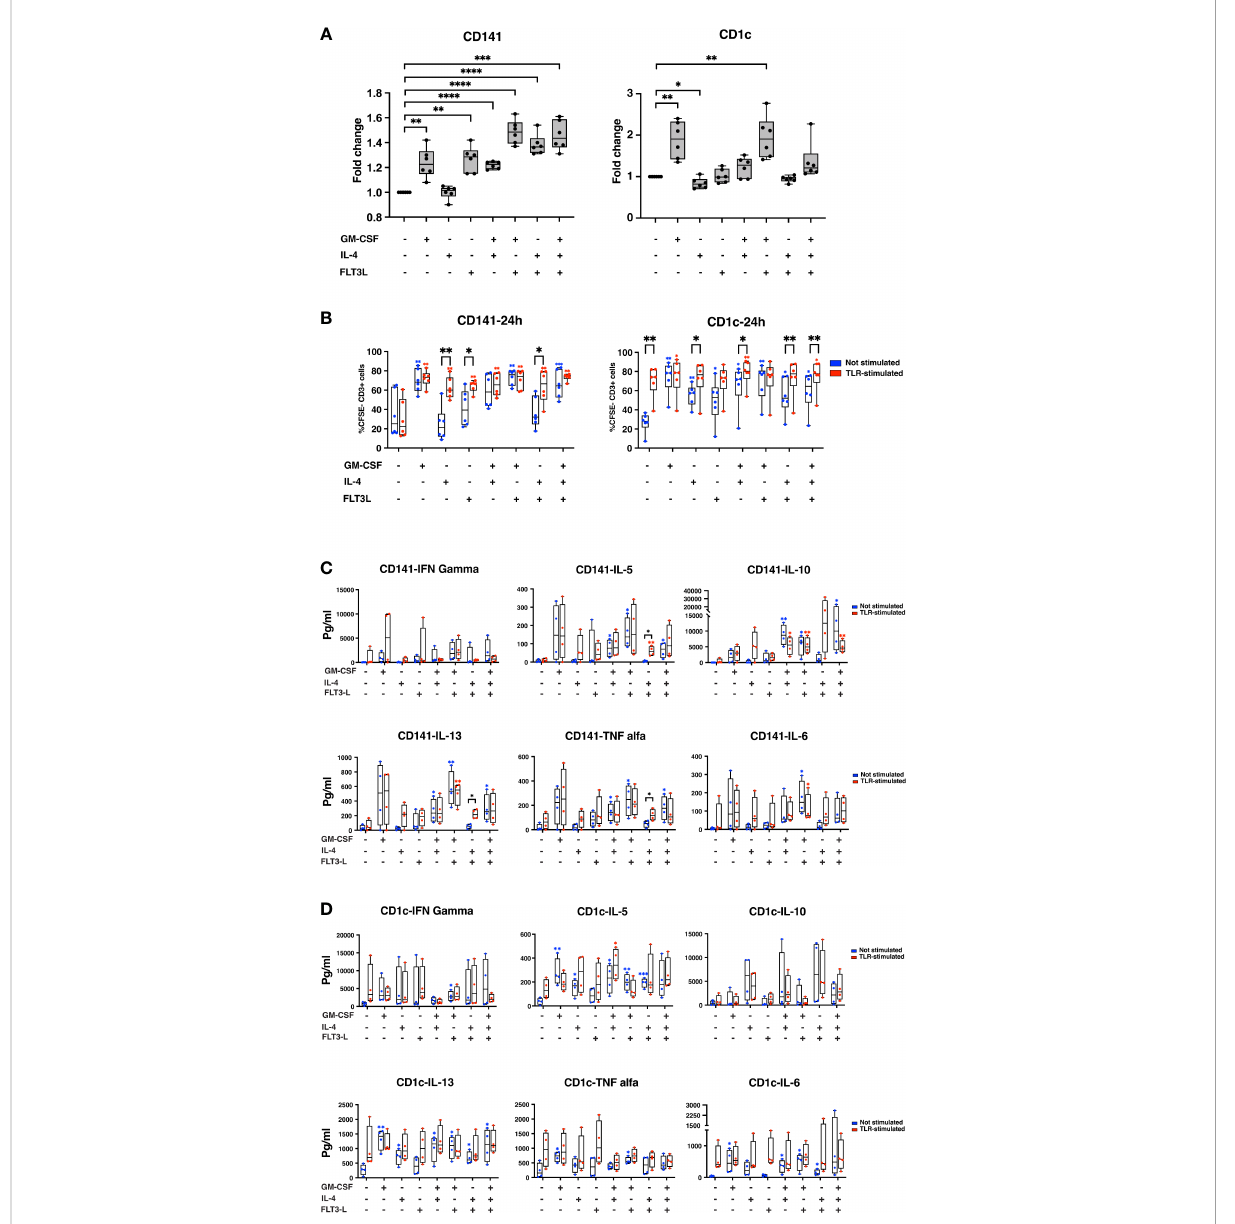
FIGURE 4 Cytokine treatment improves the performance of both CD141+ and CD1c+ cells. (A) CD141+ and CD1c+ cells were seeded in 96-well plates in different media conditions, as indicated in the graph. A day after, FITC-dextran was added to each media condition, and cells were kept at 37°C or 4°C for 90min. Those cells which were positive for FITC, are considered as cells that successfully uptake dextran-FITC. The percentage of positive cells for FITC was measured in each media condition, and the value from each condition was normalized with CTRL cells to calculate fold change. Graphs represent six biological replicates. The data is represented as fold change ± SD. Student ’ s t test analysis was used for calculation of p values ****, p < 0.0001; ***, p ≤ 0.001; **, p ≤ 0.01; *, p ≤ 0.05. (B) CD141+ and CD1c+ cells were sorted and cultured in different media conditions in the presence or absence of stimuli. After 24hrs, DCs were extensively washed and cocultured with CSFE stained monocyte-depleted PBMCs in the proportion of 1:5. “ TLR-stimulated ” denotes addition of Poly I:C to CD141+ cultures and R848 to CD1c+ cultures in contrast to “ Not Stimulated ” without these compounds. Cells were incubated at 37°C for eight days. IL-2 and IL-7 were added to the media every second day. Samples were analyzed using fl ow cytometry. Graphs indicate a summary of six biological replicates, and data represent the percentage of CSFE- CD3+ cells ± SD. Paired Student ’ s t test analysis was used for the calculation of p-values ***, p ≤ 0.001; **, p ≤ 0.01; *, p ≤ 0.05. (C, D) Media of MLR experiments were collected after eight days, and cytokine secretion was analyzed for each treatment as indicated. The data are shown as pg/ml, and paired student ’ s t test analysis was used for the calculation of p value ***, p ≤ 0.001; **, p ≤ 0.01; *, p ≤ 0.05. Graphs summarized results from four biological replicates. In (B-D) , the blue star showing summary of p values for not stimulated samples in comparison with control cells, and red star showing summary of p value for stimulated samples in comparison with stimulated- CTRL. The black stars show the summary of p values where not-stimulated and TLR-stimulated samples were compared in each cytokine treatment